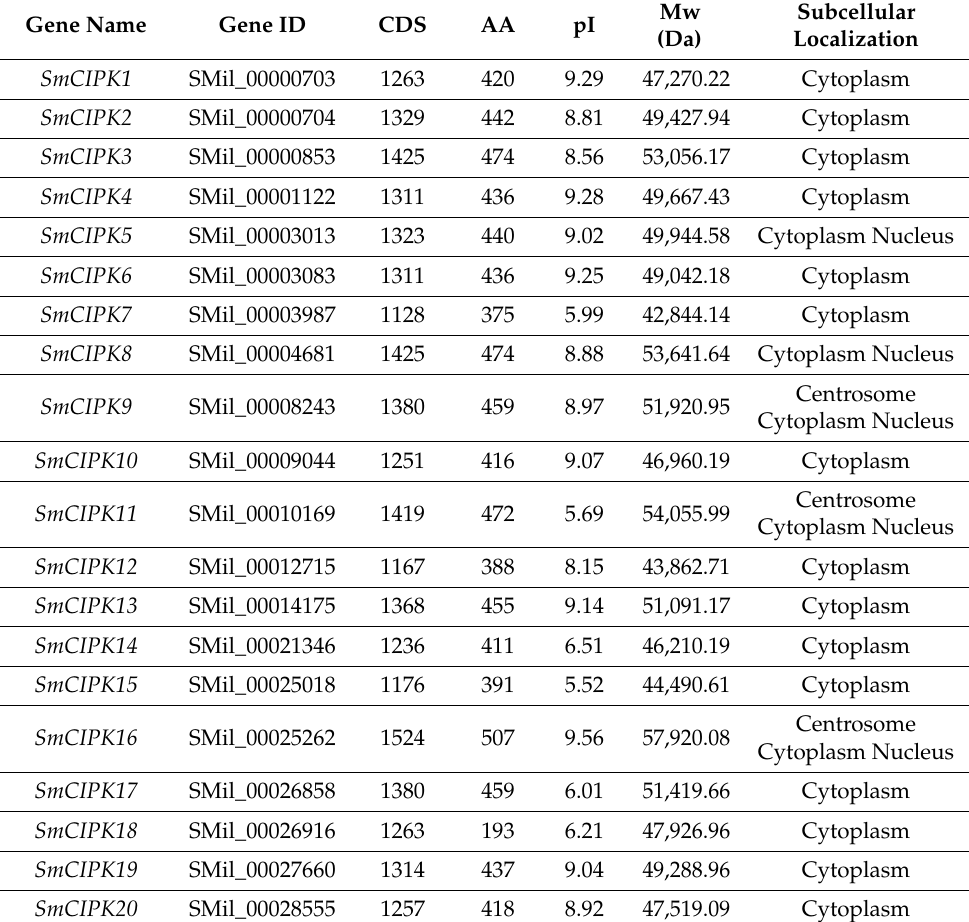
Table 1. Physiological characterization of SmCIPKs